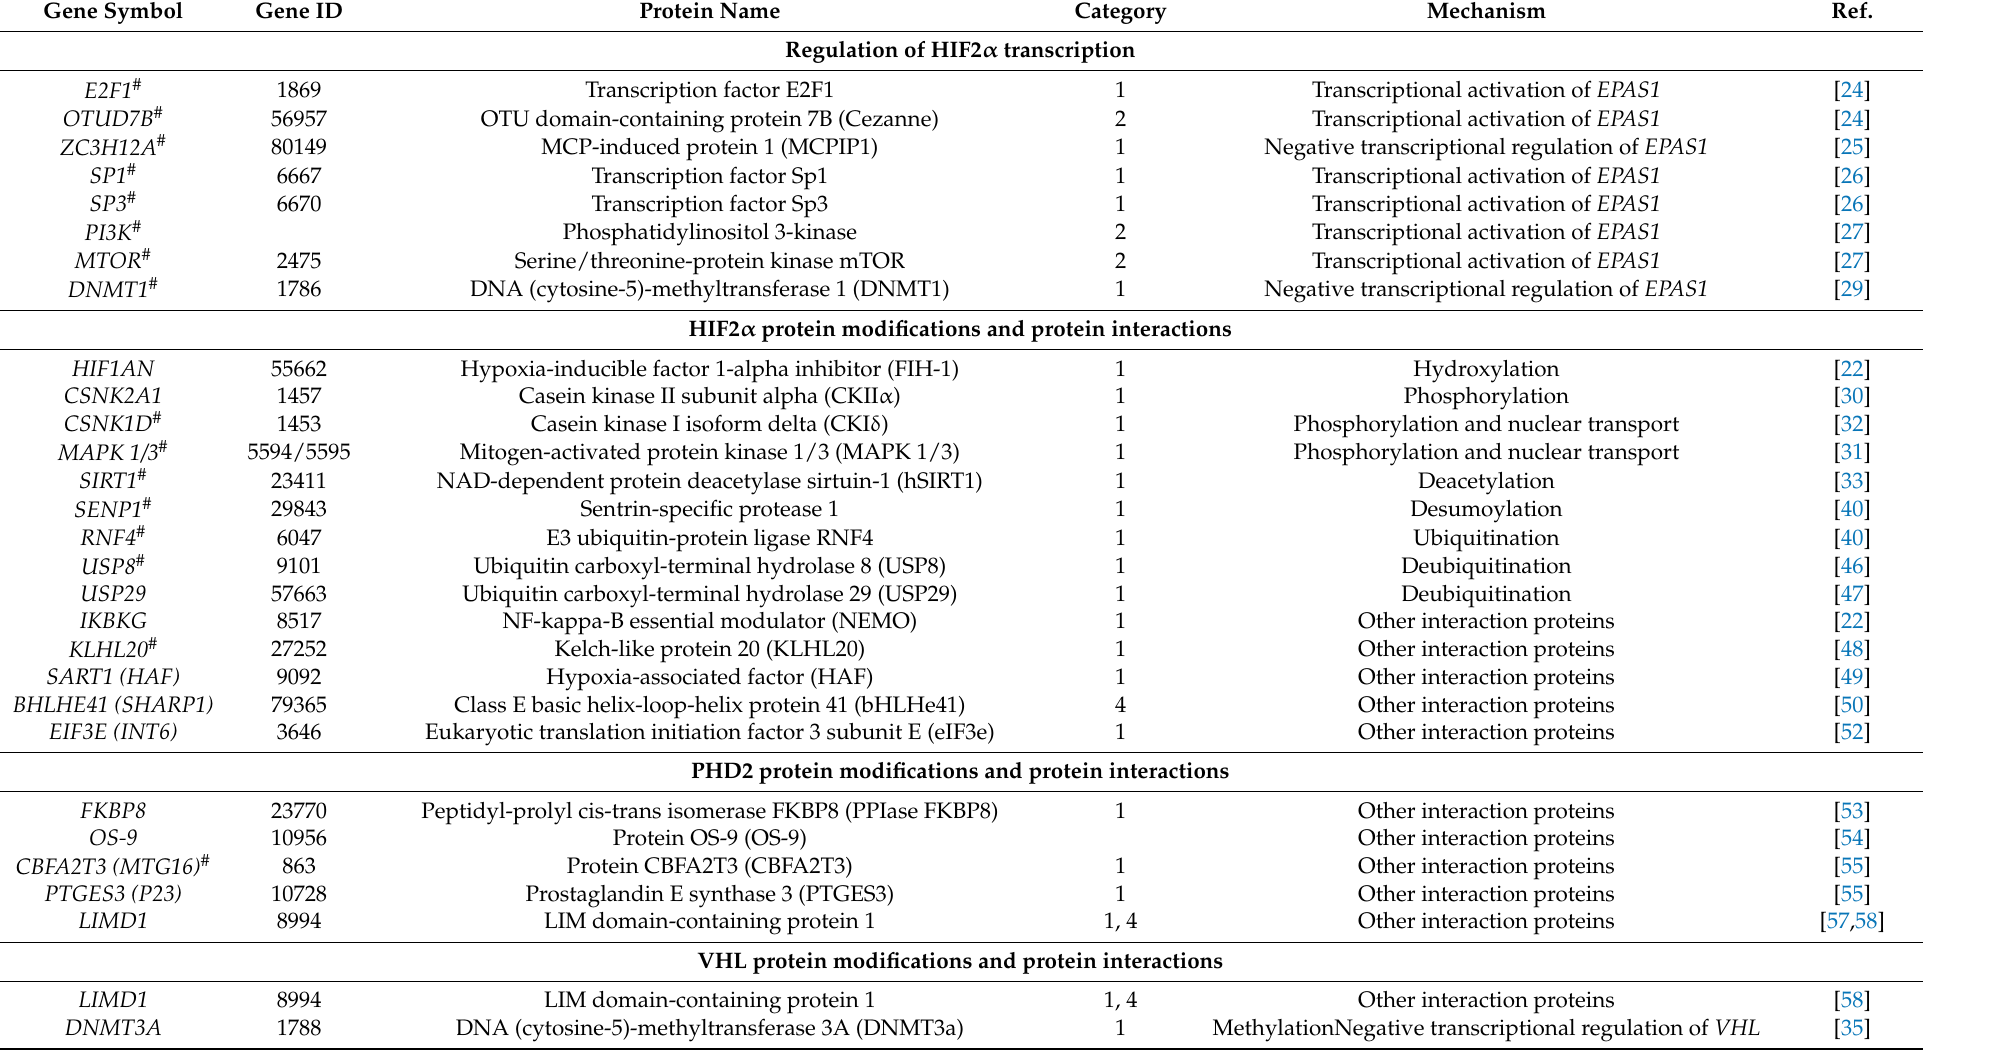
Table 2. Genes and molecular mechanisms correlated with erythropoiesis in the HIF-EPO